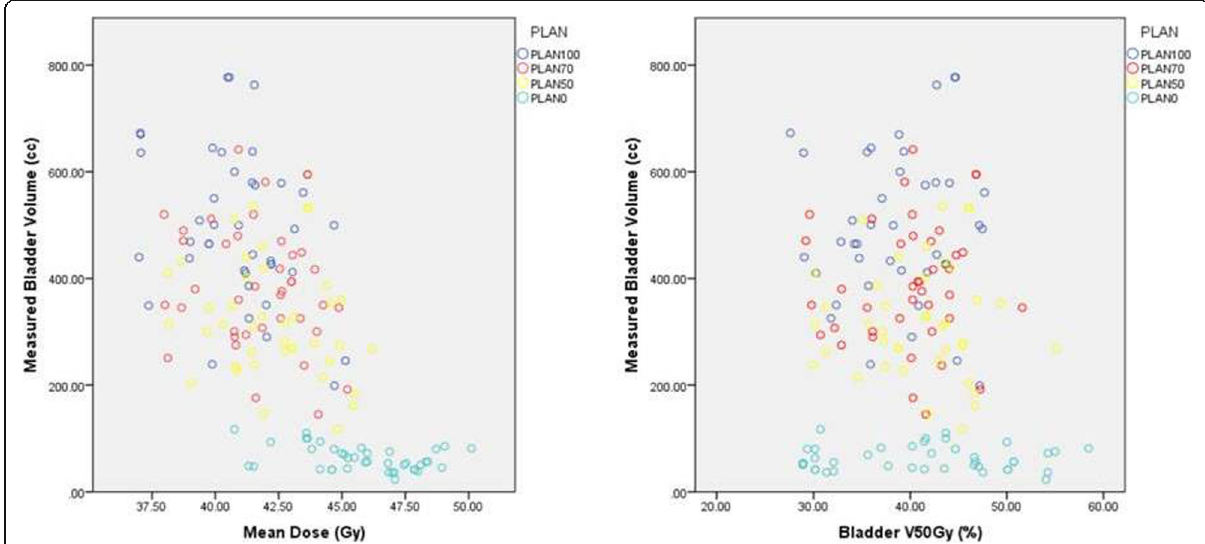
Fig. 1 Scatterplot showing correlation between bladder volumes and corresponding mean dose and V 50 Gy of the bladder for different plans